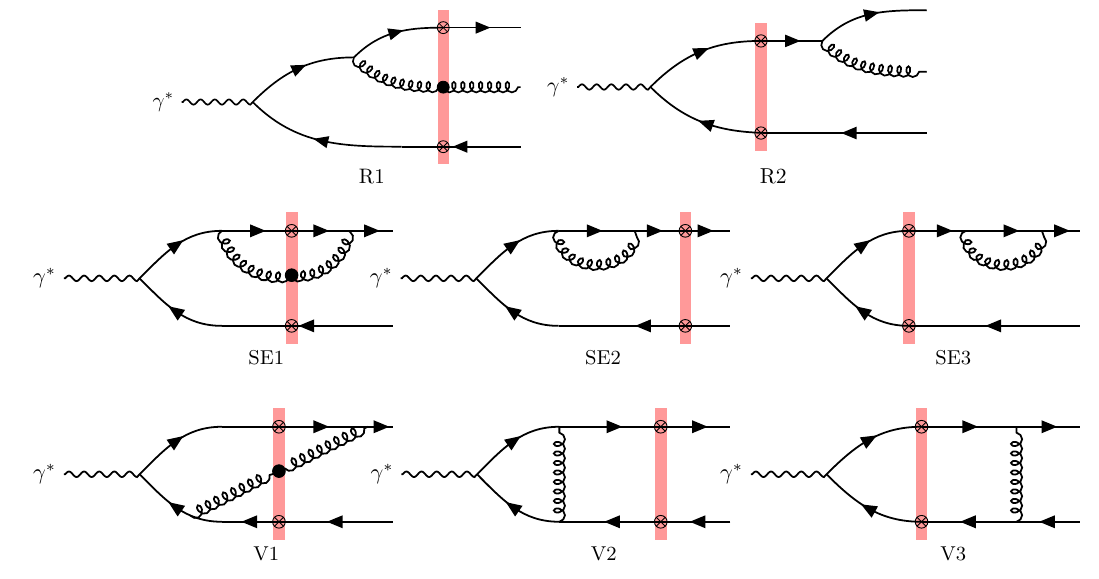
Figure 1 . Feynman diagrams that appear in the production of dijets at NLO. Top: real gluon emission diagrams. Middle: self energy diagrams. Bottom: vertex correction diagrams. Diagrams obtained from q ↔ ¯ q interchange are not shown, and are labeled with an additional prime index, for example, R 2 → R 0 . Only the diagrams in which the gluon does not scatter off the shockwave 2 contribute to the Sudakov double and single